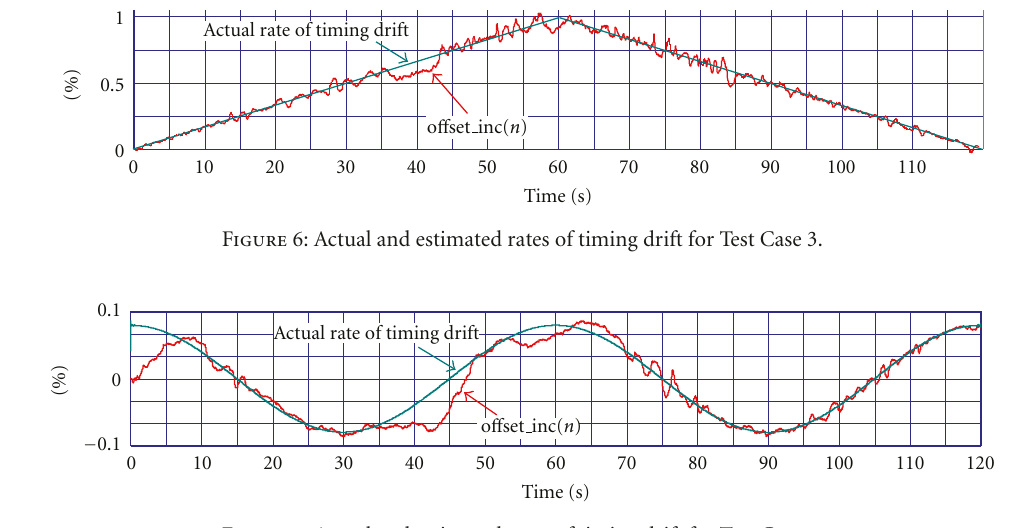
Figure 7: Actual and estimated rates of timing drift for Test Case 5.